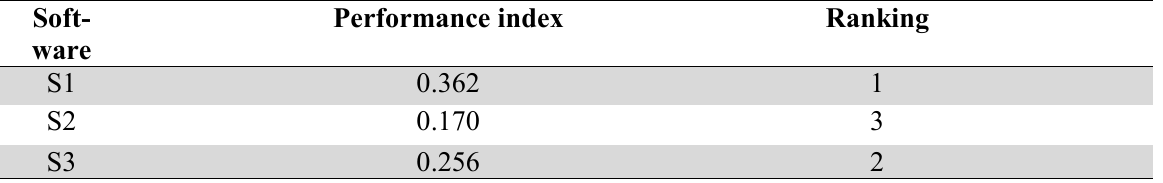
Ranking of software for maintainability using performance